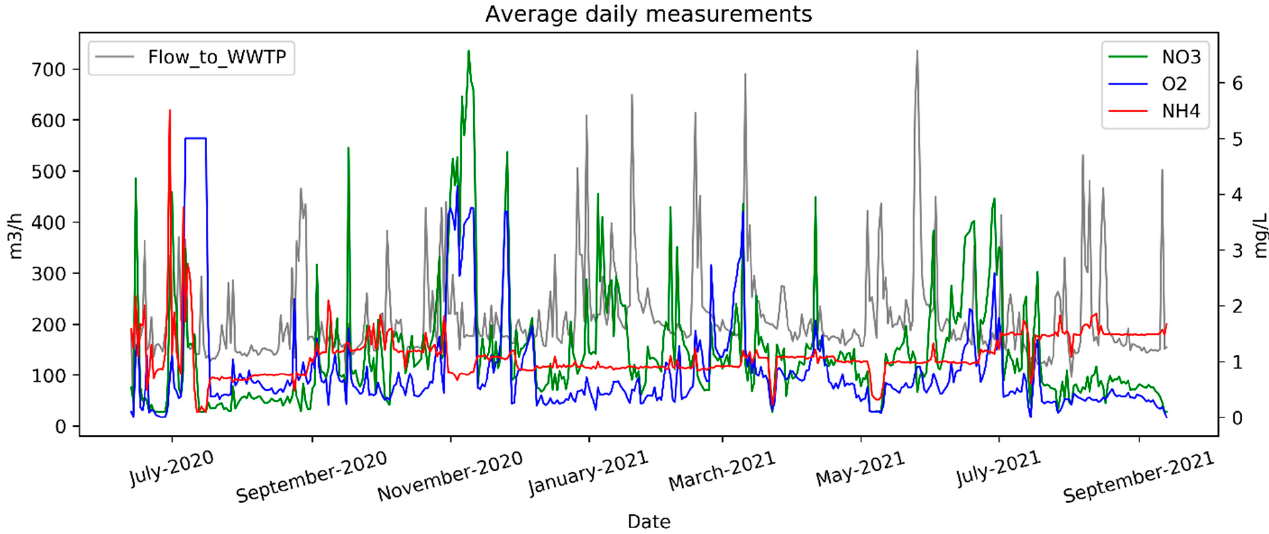
Figure 12. Average daily values of Flow, NH 4 , NO 3 and DO in WWTP2 PCT1.